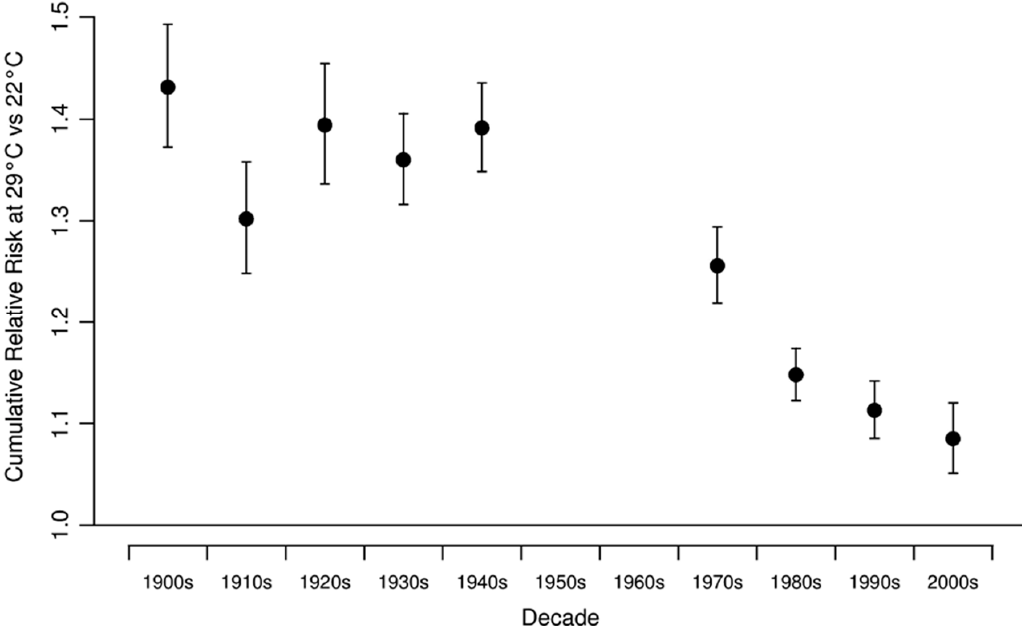
Figure 3. Decadal heat relative risks and 95% confidence intervals in NYC. Note that there is a data gap in mid ‐ century. From Petkova et al., 2014 [28].